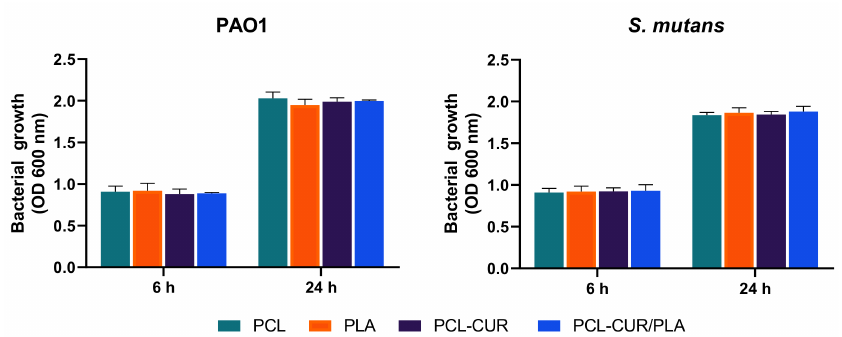
Figure 7. Antibacterial activity evaluated at 600 nm against Pseudomonas aeruginosa PAO1, and Streptococcus mutans . Bacterial growth in the presence of PCL and PLA were used as controls. For each sample, six different experiments were conducted, and the results expressed as the mean of the values obtained (mean ±